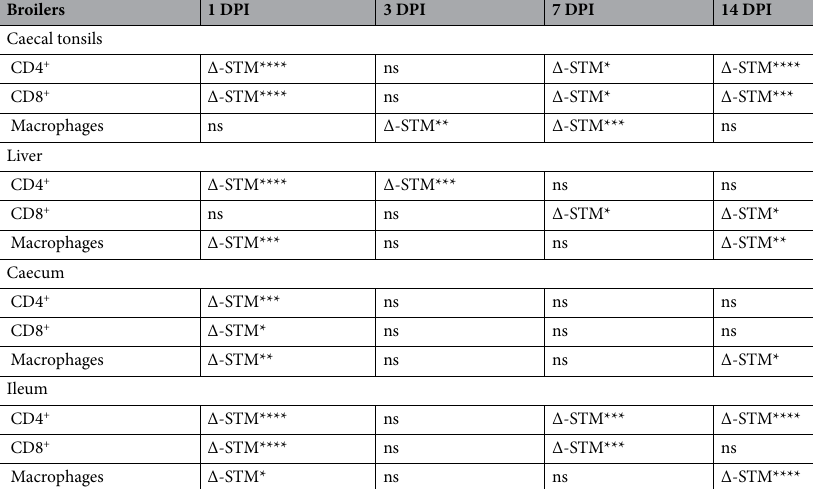
Table 4. Representation of the significant difference related to the quantitative distribution of different immune response cells in organs of broilers infected with Salmonella Typhimurium wild and mutant strains at different days post-infection. DPI, days post-infection; ∆-STM, Salmonella Typhimurium ∆ ttr A∆ pdu A; wt-STM, Salmonella Typhimurium wild-type; ns, no significant difference. Within each organ and DPI, * means difference by two-way ANOVA followed by Bonferroni’s comparison test between wild and mutant strains values (*P ≤ 0.05; **P ≤ 0.01; ***P ≤ 0.001; ****P ≤ 0.0001). The strain presented in the table (∆-STM or wt-STM) as significant within the organ and DPI is that shown the major infiltration area to each cell.